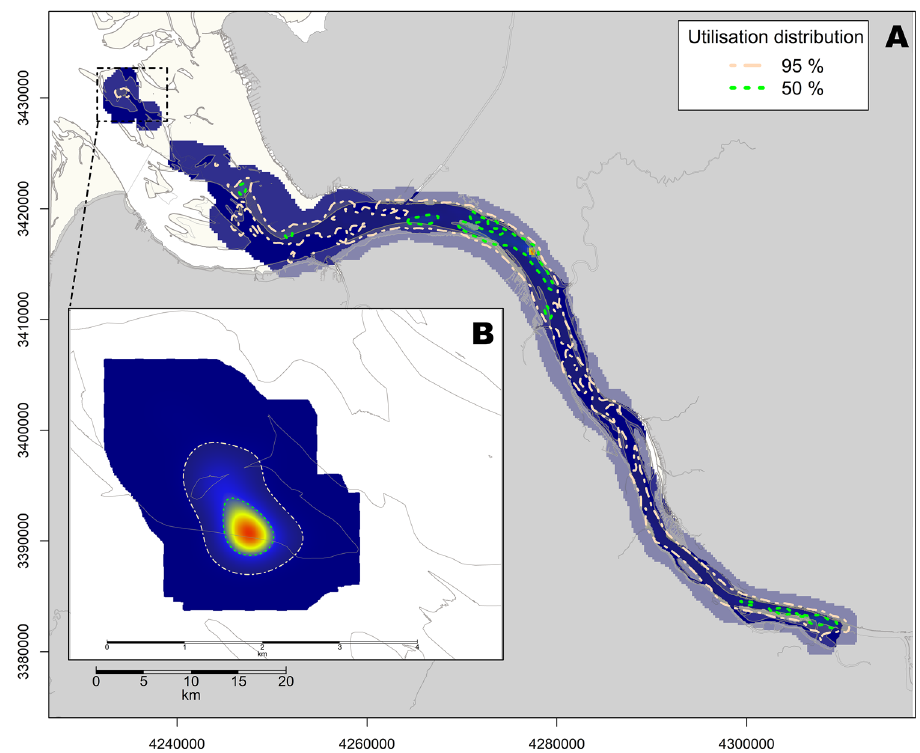
Figure 10. Home range inferred from the calculated utilisation distribution with the large map showing the home range for the period outside the presumed reproductive period and the small map showing the home range during the presumed reproductive period for female seal_3. 50% HR: green dashed line, 95% HR: beige dashed line. Light yellow areas represent intertidal habitat. Visualisation was done in R! 3.6.2 35 using R